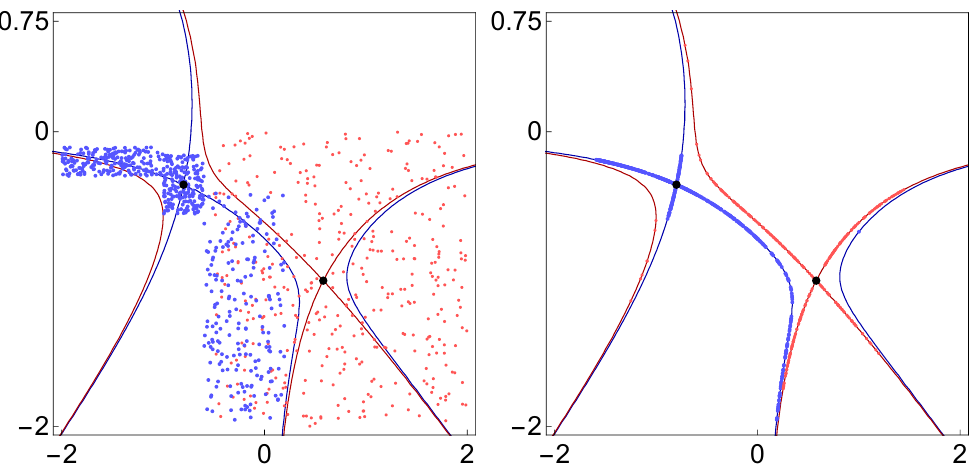
Figure 2: Complex plane with the solutions to the gradient equations (11) for a given grid of initial conditions for the left thimble (blue) and the right thimble (red). In the left plot we show a possible choice of initial conditions for the gradient equations. The right plot depicts the resulting distribution of points lying on the thimble and anti-thimble. Moreover other curves not passing through the fixed point on which the imaginary part of the action is constant are hit by the